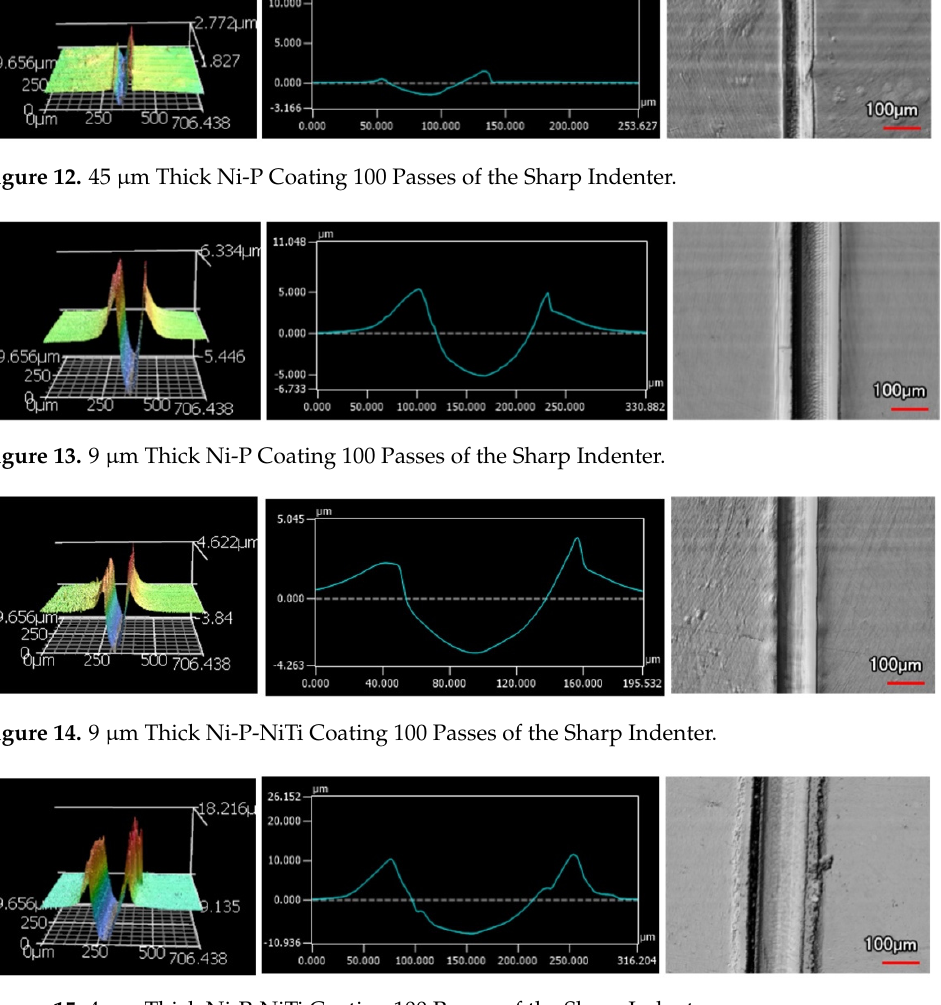
Figure 15. 4 μ m Thick Ni-P-NiTi Coating 100 Passes of the Sharp Indenter.